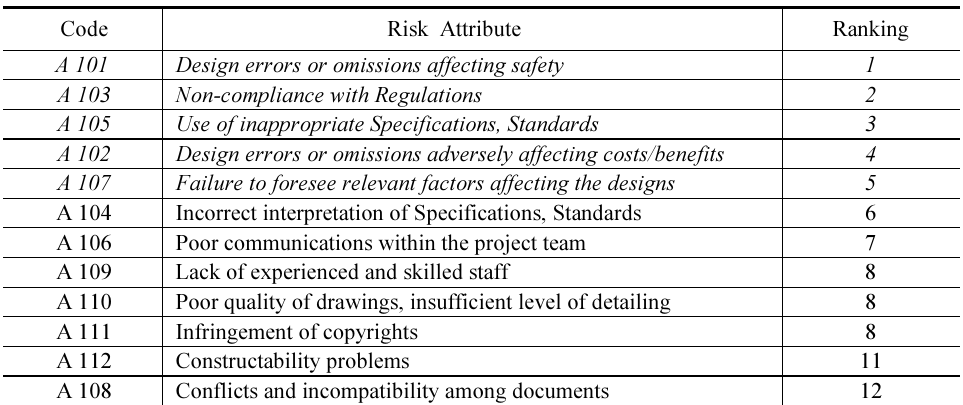
Table 3. Sample of ranking of Risk